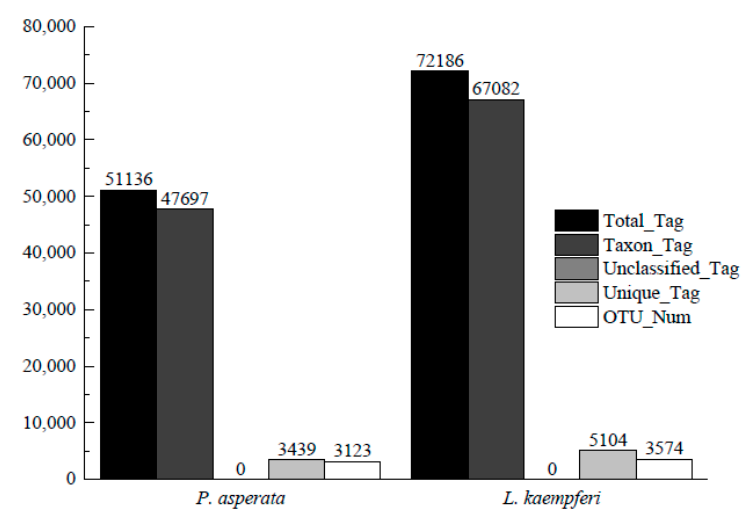
Figure 5. Taxa dynamics of soil bacterial communities. Bacteria community composition differed between two forest types in relative abun- dance profiles. Across all samples, 44 distinct bacteria phyla were detected, among which the top five phyla ( Proteobacteria , Acidobacteria , Verrucomicrobia , Bacteroidetes , and Firmicutes ) comprised more than 85% of all abundance in bacteria communities. Bacteria commu- nity composition differed substantially between locations at phyla level, such as bacteria communities of P. asperata forest enriched for Proteobacteria (49.98%), while Acidobacteria in L. kaempferi forest (35.57%) was much more abundant than that in P. asperata forest (21.01%) (Figure 6, Table S2).